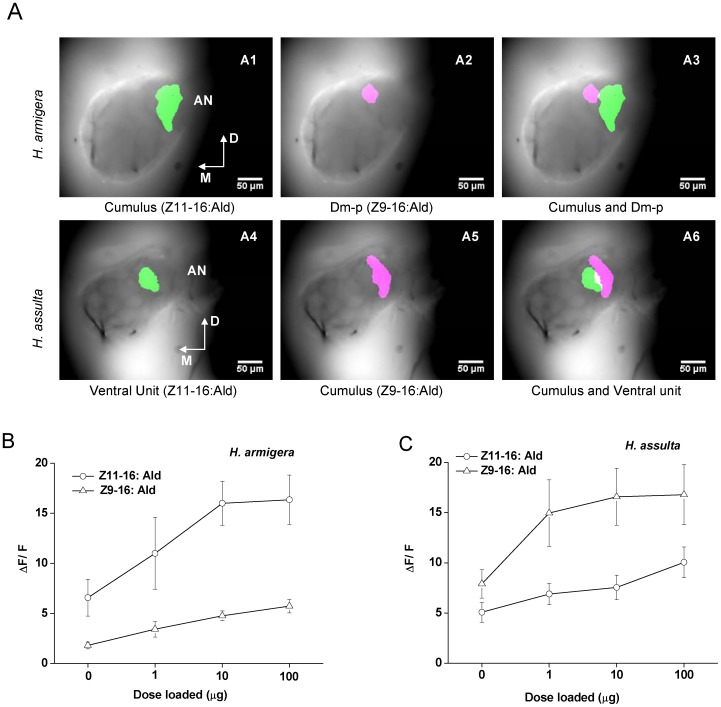
Spatial representation and dose-responses of Z11–16: Ald and Z9–16: Ald in the antennal lobes (AL).Green was chosen for activated area of Z11–16: Ald and pink for Z9–16: Ald. A, A1-A3 show the spatial representation and relative position of Z11–16: Ald and Z9–16: Ald in the AL of H. armigera, A4-A6 show those of H. assulta. D,dorsal; M, medial; Dm-p, posterior dorsomedial unit. B, Dose-response curve of Z11–16: Ald and Z9–16: Ald in the AL of H. armigera. C, Dose-response curve of Z11–16: Ald and Z9–16: Ald in the AL of H. assulta. Values are mean ± SEM (H. armigera, n = 5; H. assulta; n = 7).